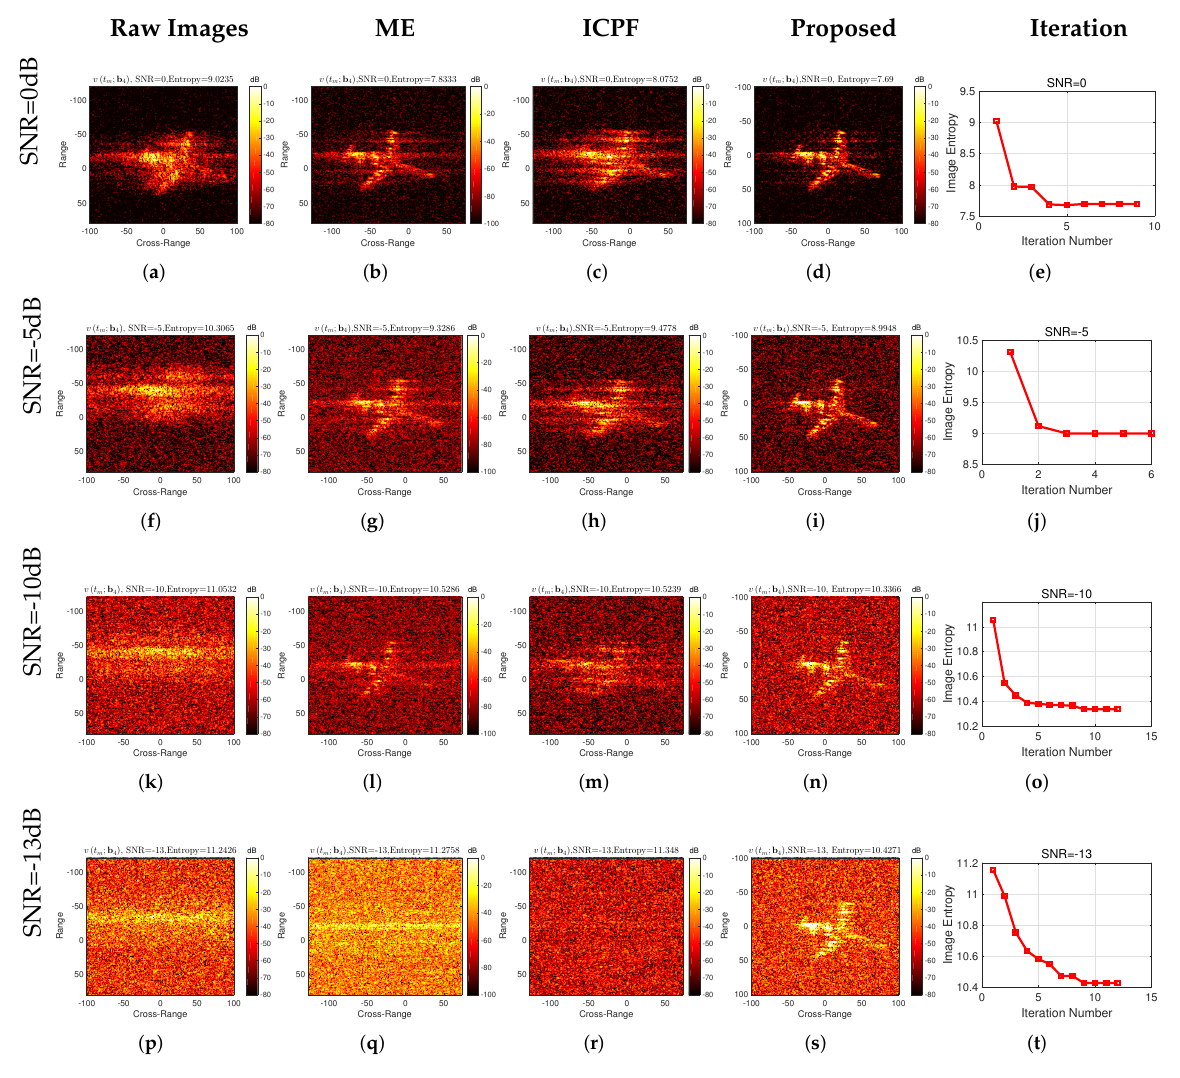
Figure 16. Experimental results of Yak-42 measured data under different SNRs.